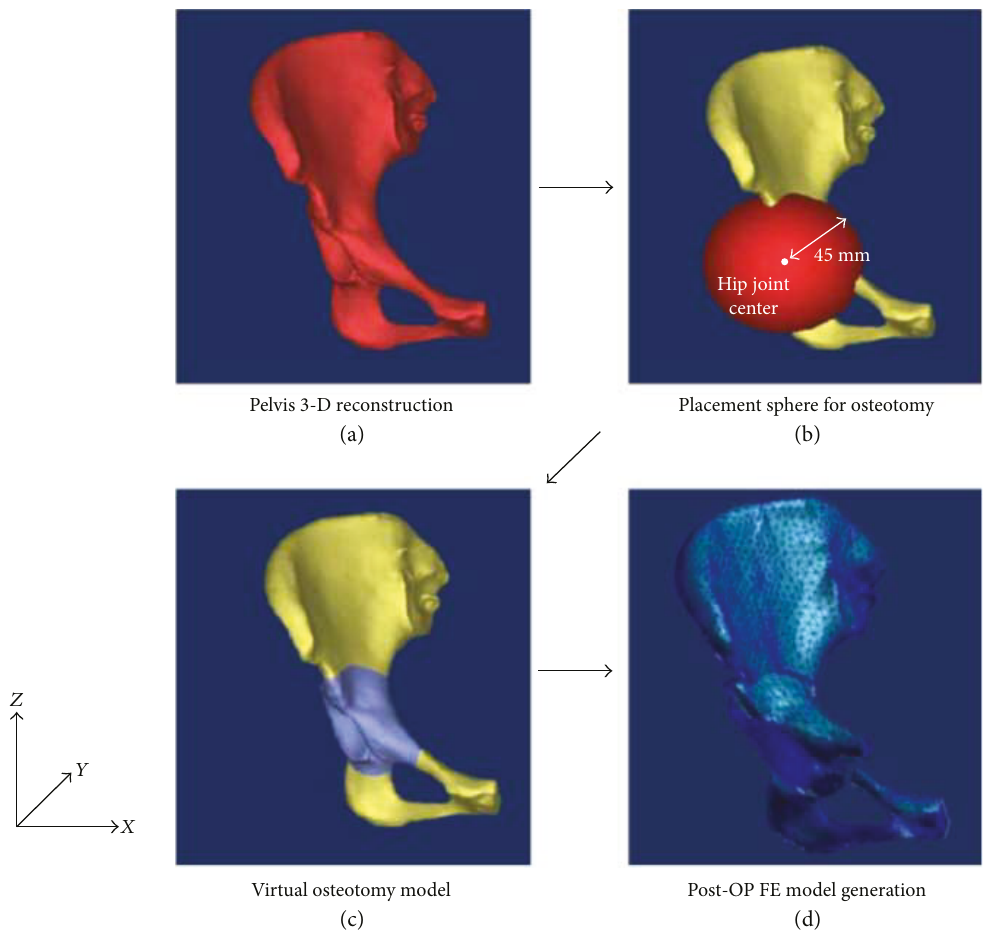
Figure 4: Procedure of the virtual PAO surgery: (a) 3-D reconstruction of the patient ’ s pelvis, (b) superposition of the sphere ( r = 45mm ) on the periphery of the acetabulum for osteotomy, (c) Boolean process to cut the pelvis and the acetabulum, and (d) 3-D rotation of the osteotomized acetabulum. Table 2: Changes in anatomical angles of Post-OP models due to incremental increase in acetabulum rotations. The “ ∗ ” sign indicated to be within the normal